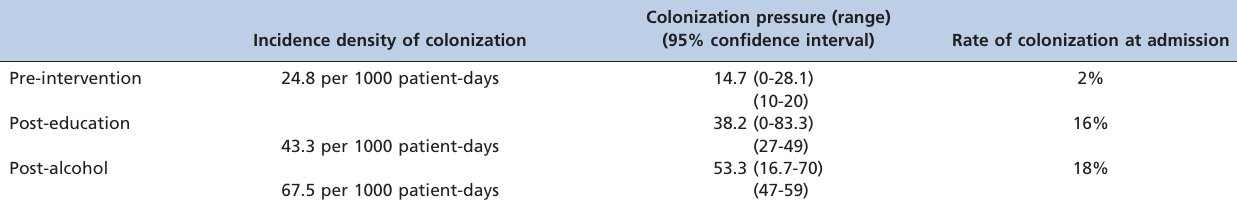
Table 2 - Incidence density of colonization, colonization pressure and rate of colonization at ICU admission during the three study periods.